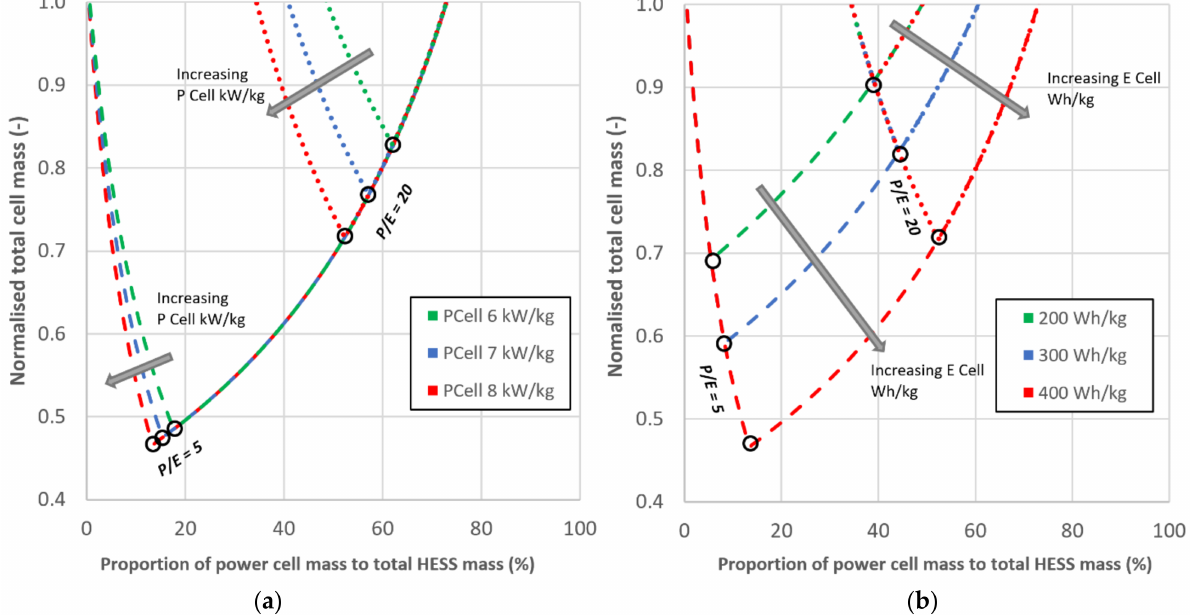
Figure 4. Overall total cell mass for varying the power-cell-to-total-cell mass ratio considering the impact of ( a ) power cell power density increases from 6 to 8 kW/kg and ( b ) energy-dense cell energy density increases from 200 to 400